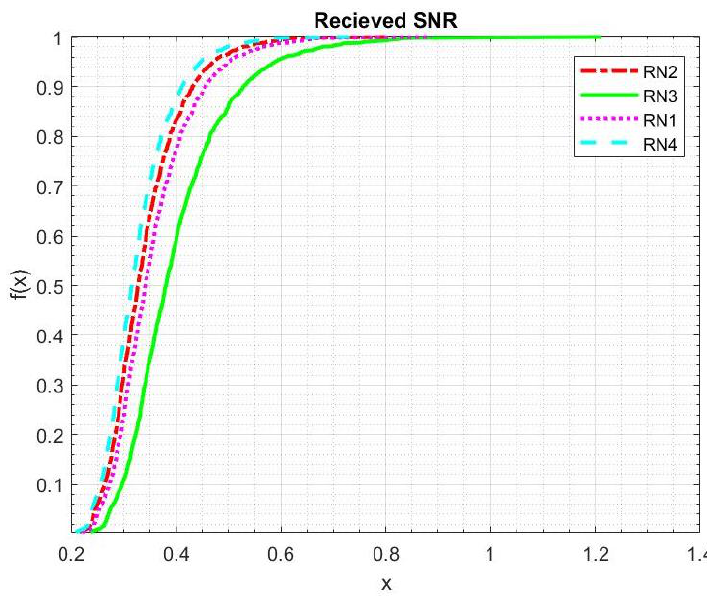
Figure 9. SNR of four